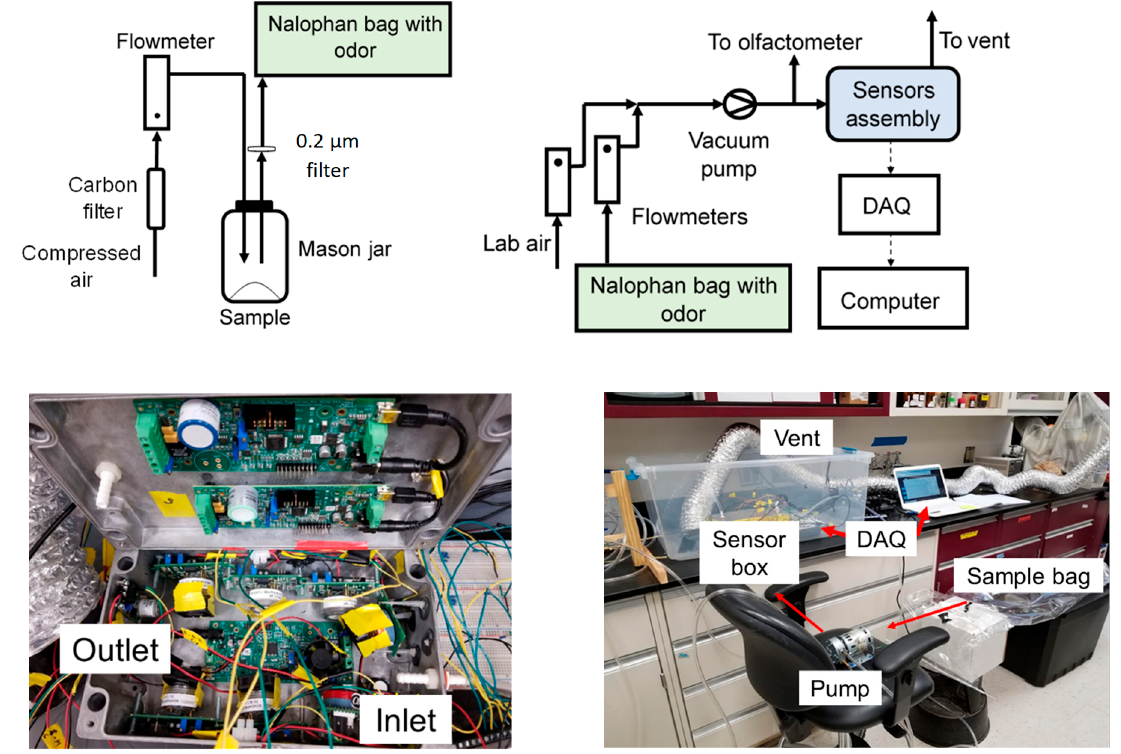
Figure 1. Schematic of the experimental setup for odor generation and collection ( top left ), and odor analysis ( top right ), and pictures of the sensor box ( bottom left ) and of the overall test system ( bottom right ).